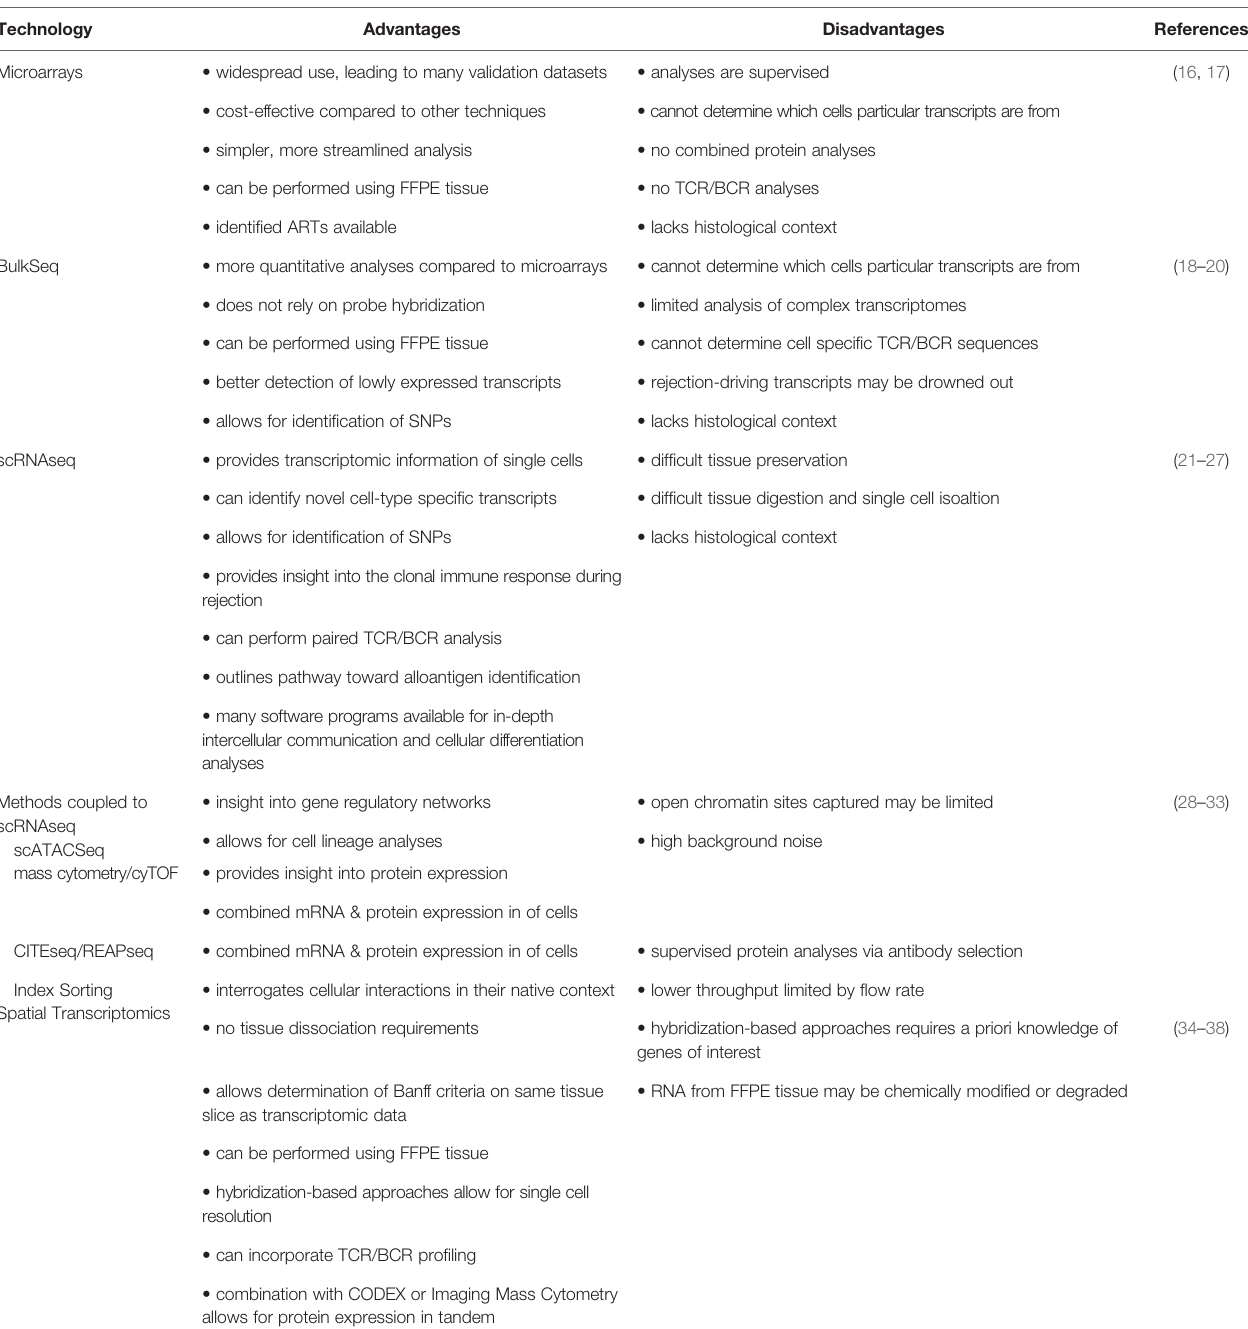
TABLE 1 | Advantages and Disadvantages of Advanced Geomics-Based